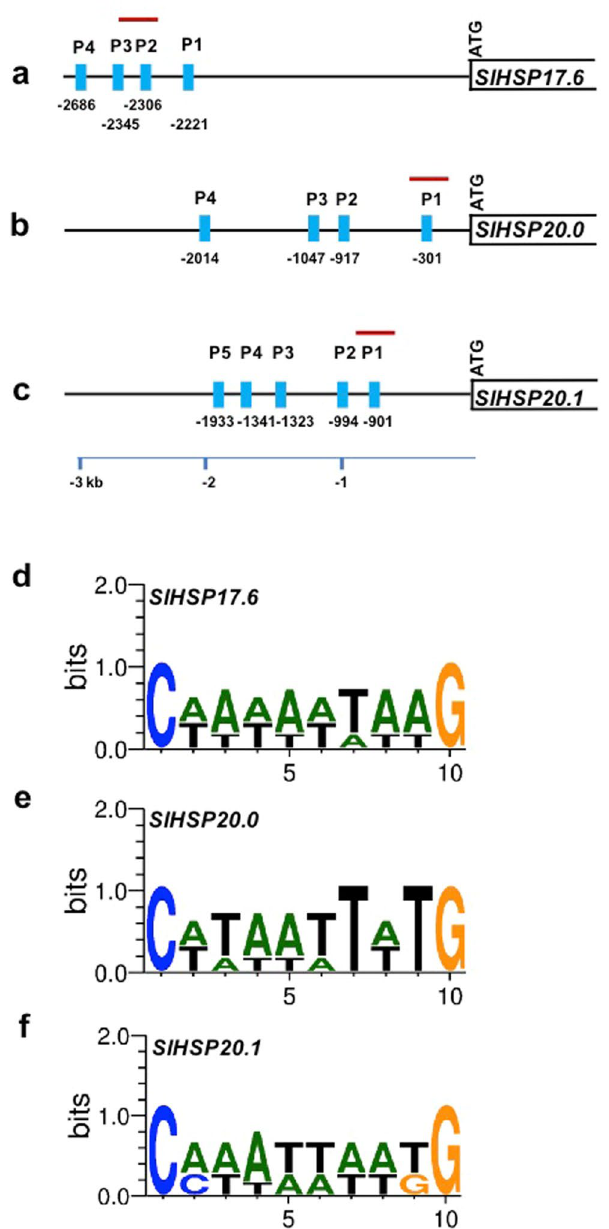
Figure 5. In silico analysis of class-I SlHSP ( 17 . 6 , 20 . 0 , 20 . 1 ) gene promoters. Promoter regions ( ≈ 3 kb of the 5 ′ upstream region of the start codon) of tomato SlHSP17 . 6 , SlHSP20 . 0 and SlHSP20 . 1 genes were extracted using the International Tomato Genome Sequencing Consortium (SGN) database (version ITAG 2.4). Two databases, Plant CARE relational database 35 and PLACE, the plant- cis -acting regulatory DNA elements database 25 were used for plant cis- element search in the promoters of the described SlHSP genes. The possible RIN binding CArG-box motif sequences are [{C(C/T) (A/T)6(A/G)G}, {C(A/T)8G} and {C(C/T)(A/T)G(A/T)4 (A/G)G}] 38, 39 . All the CArG motifs found in SlHSP gene promoters are listed in Supplementary Table S2. The promoter position(s) significantly enriched in ChIP assay are highlighted with horizontal red line. ( a ) SlHSP17 . 6 gene promoter contains CArG cis element positions (here denoted as ‘P’), respectively at P1 ( − 2221), P2 ( − 2306), P3 ( − 2345) and P4 ( − 2686). ( b ) SlHSP20 . 0 gene promoter contains four CArG motifs positioned at P1 ( − 303), P2 ( − 917), P3 ( − 1047) and P4 ( − 2014), respectively. ( c ) SlHSP20 . 1 gene promoter harbors five CArG cis elements, positioned at P1 ( − 901), P2 ( − 994), P3 ( − 1323), P4 ( − 1341) and P5 ( − 1933). ( d , e , f ) show corresponding conserved locations and their distribution patterns in the 10 bp consensus sequence described in the